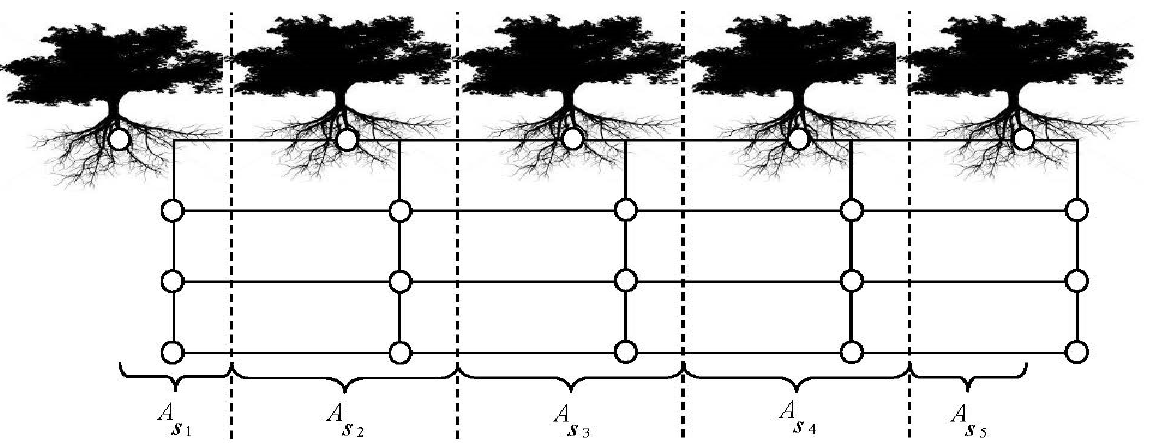
A = Surface area for node i at s i